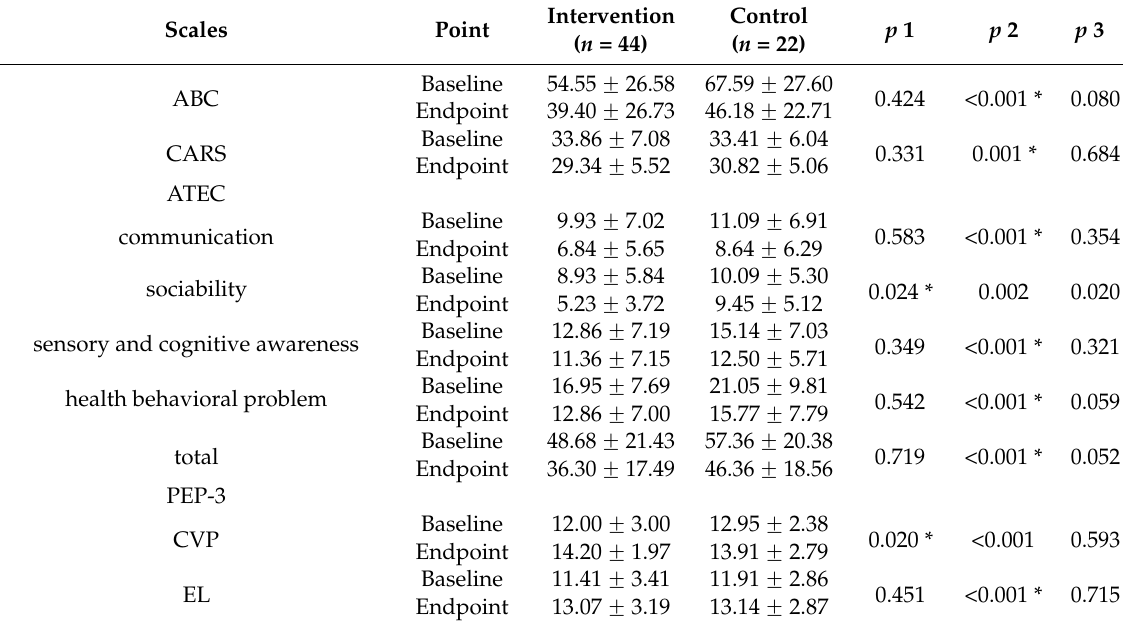
Table 2. Scores from ATEC and PEP-3 at baseline and after the three-month folic acid intervention in the intervention and control groups,